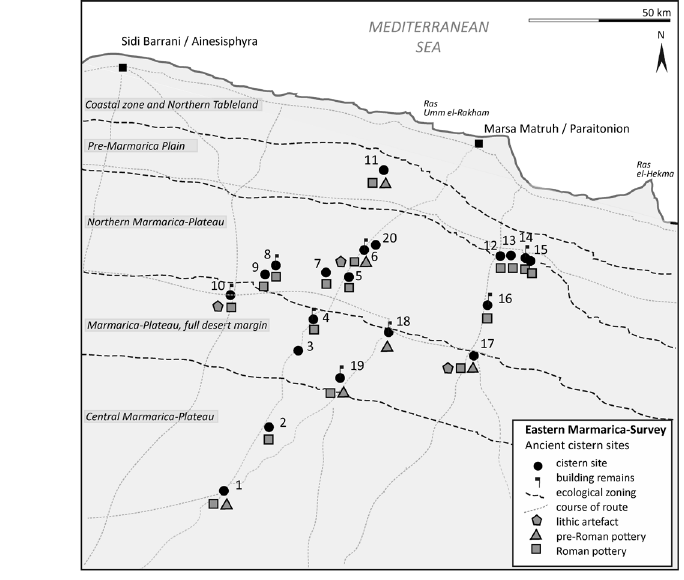
Fig. 4. Cistern sites on the Marmarica-Plateau as surveyed by the “Eastern Marmarica Survey”. 1 Bir el-Nuss, 2 Bir Fuad, 3 Bir Istabl, 4 Bir Hilw, 5 Bir Emtiha, 6 Abar el-Kanayis, 7 Bir el-Awra, 8 Bir Abu el-’Igl, 9 Bir el-Qatir, 10 Bir Qatrani, 11 Abar Abu Imama, 12 Bir Abu Shayit, 13 Bir Abu Batta, 14 Bir Siayim, 15 Bir Abu Kirdu, 16 Bir Khalda, 17 Bir Abu Mukhayat, 18 Bir Quseir,